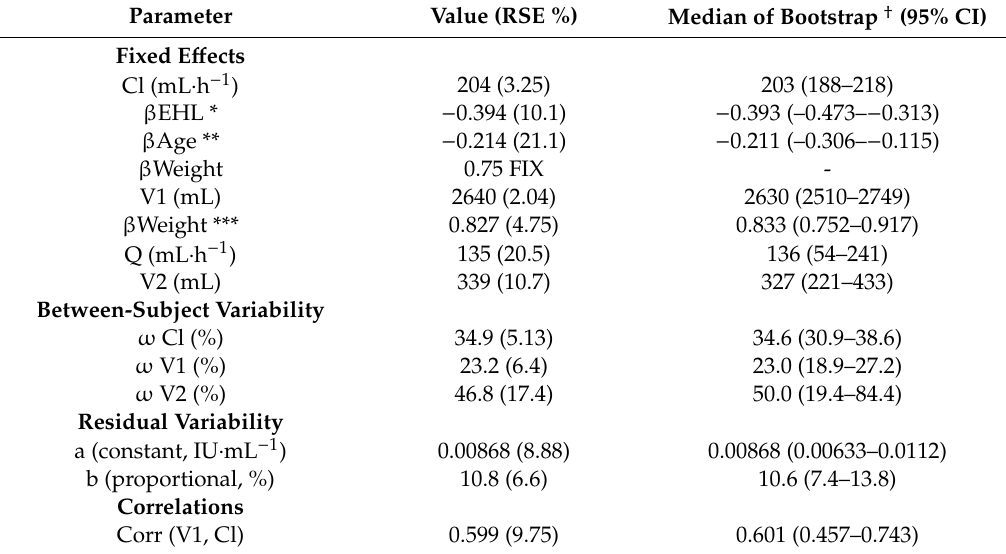
Table 2. Estimates of the population pharmacokinetics